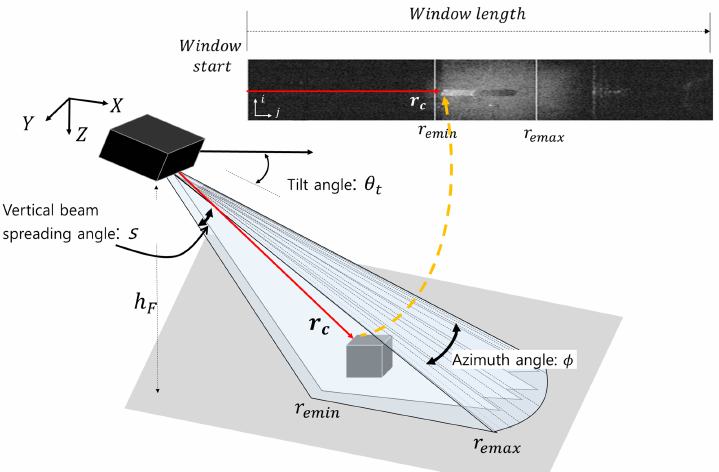
Figure 1. Acoustic beam geometry of the FLS and sonar image generation.